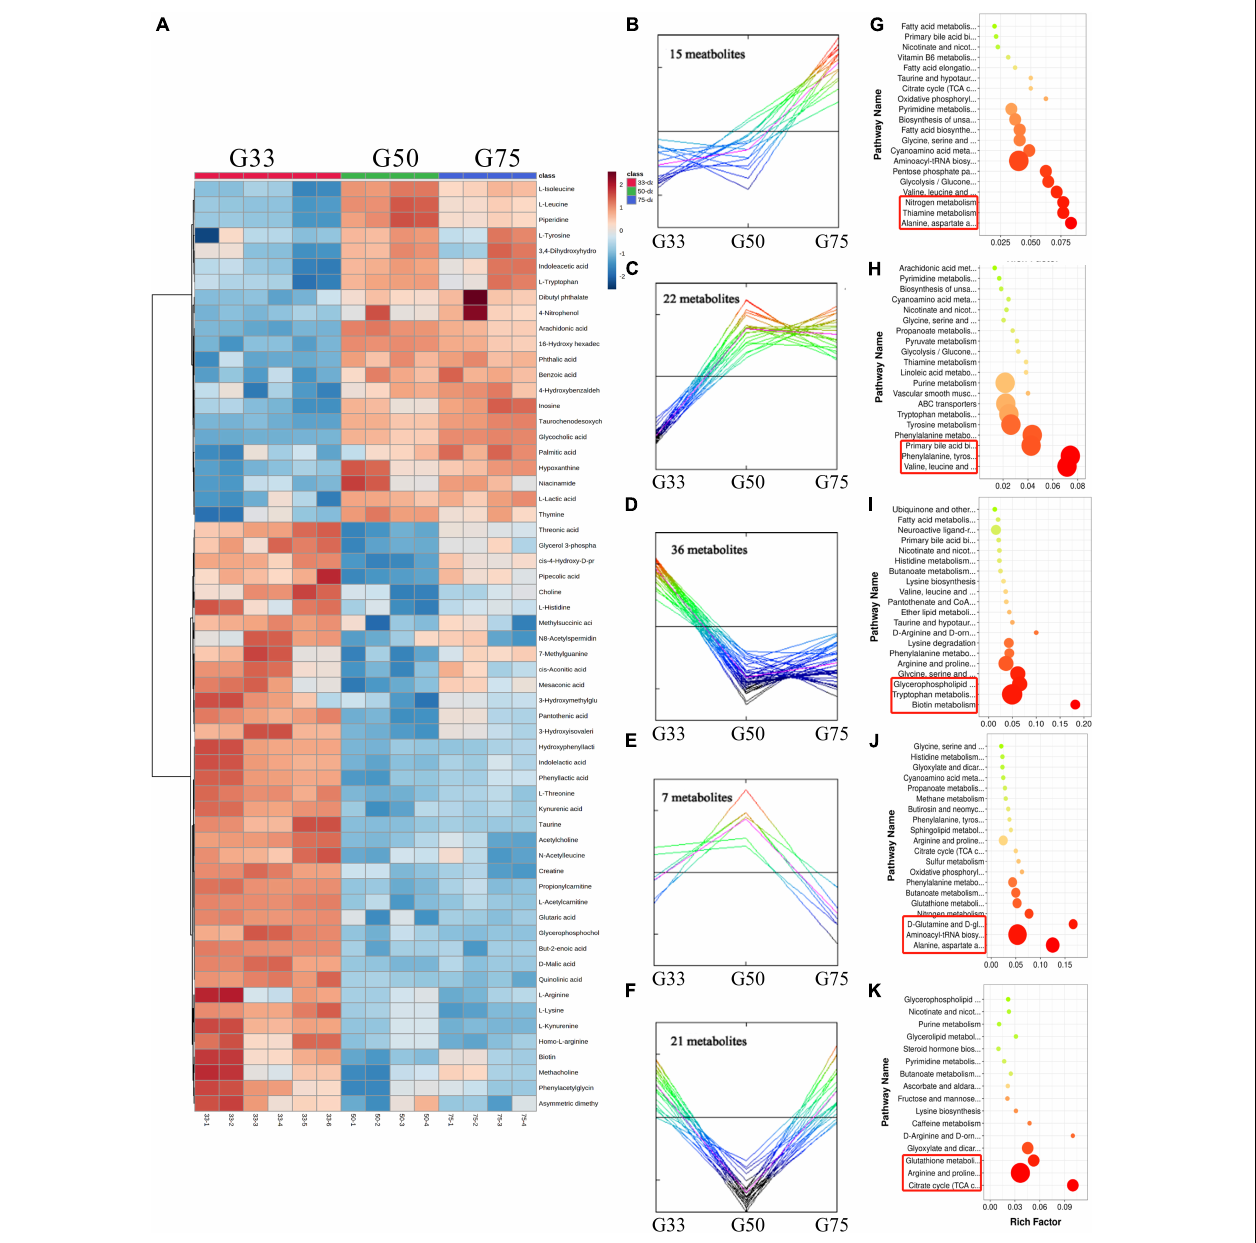
FIGURE 5 | Amniotic fluid metabolome analysis of Tibetan sows at different gestation periods. (A) Heatmap of the major differential metabolites in the amniotic fluid of Tibetan sows at different gestation periods; (B–F) Cluster analysis of differential metabolites; (G–K) The enriched KEGG pathways for each